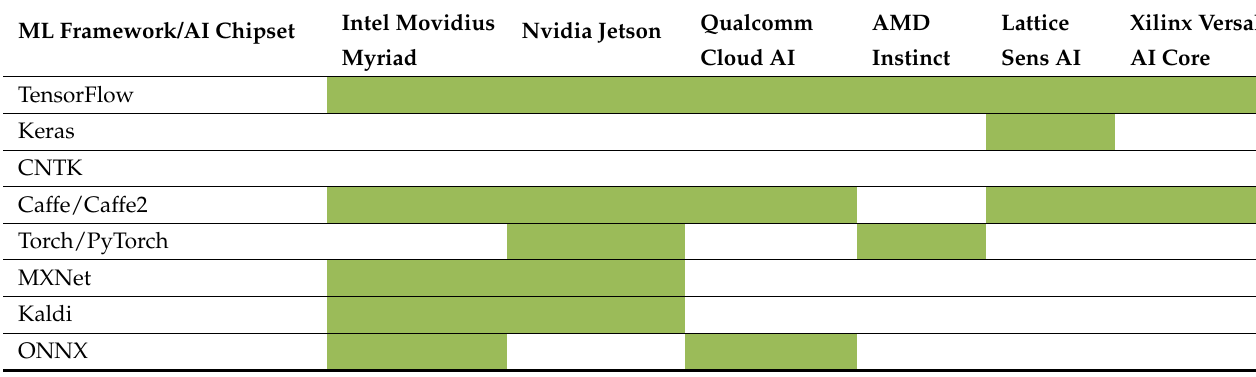
Table 6. ML framework and AI chipset compatibility matrix.